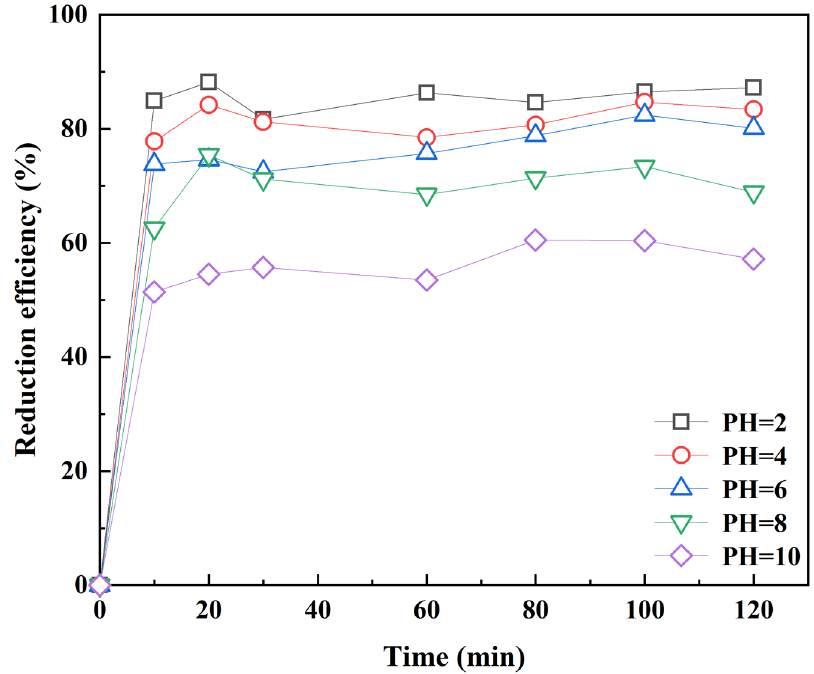
Figure 6. Effect of initial pH on Cr(VI) reduction by RC-nZVI.